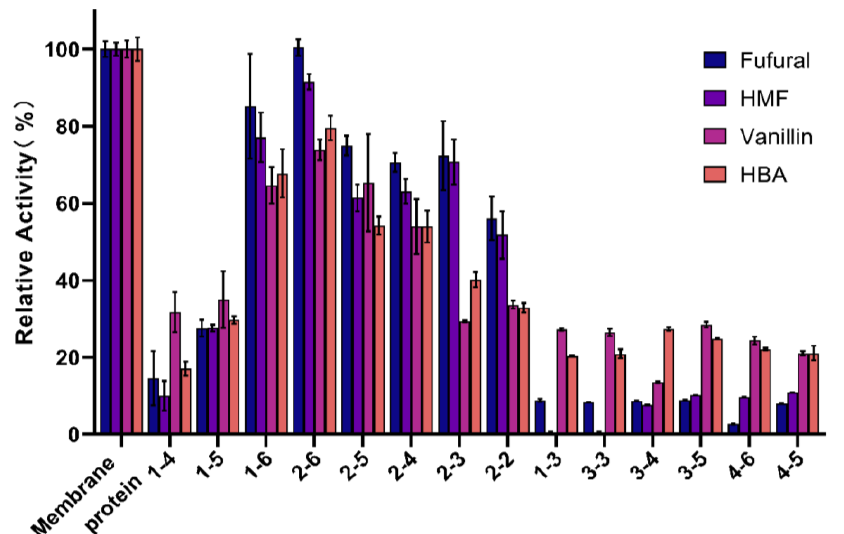
Figure 2. Comparison of the activity of each fraction of protein against four inhibitors (furfural, 5-hydroxymethylfurfural, vanillin, and 4-hydroxybenzaldehyde) collected by gel filtration chromatography. The concentration of inhibitor used was 1 g/L, and the REDOX indicator DCIP was used to indicate the degree of REDOX reaction (the viability of the membrane component was 100%).